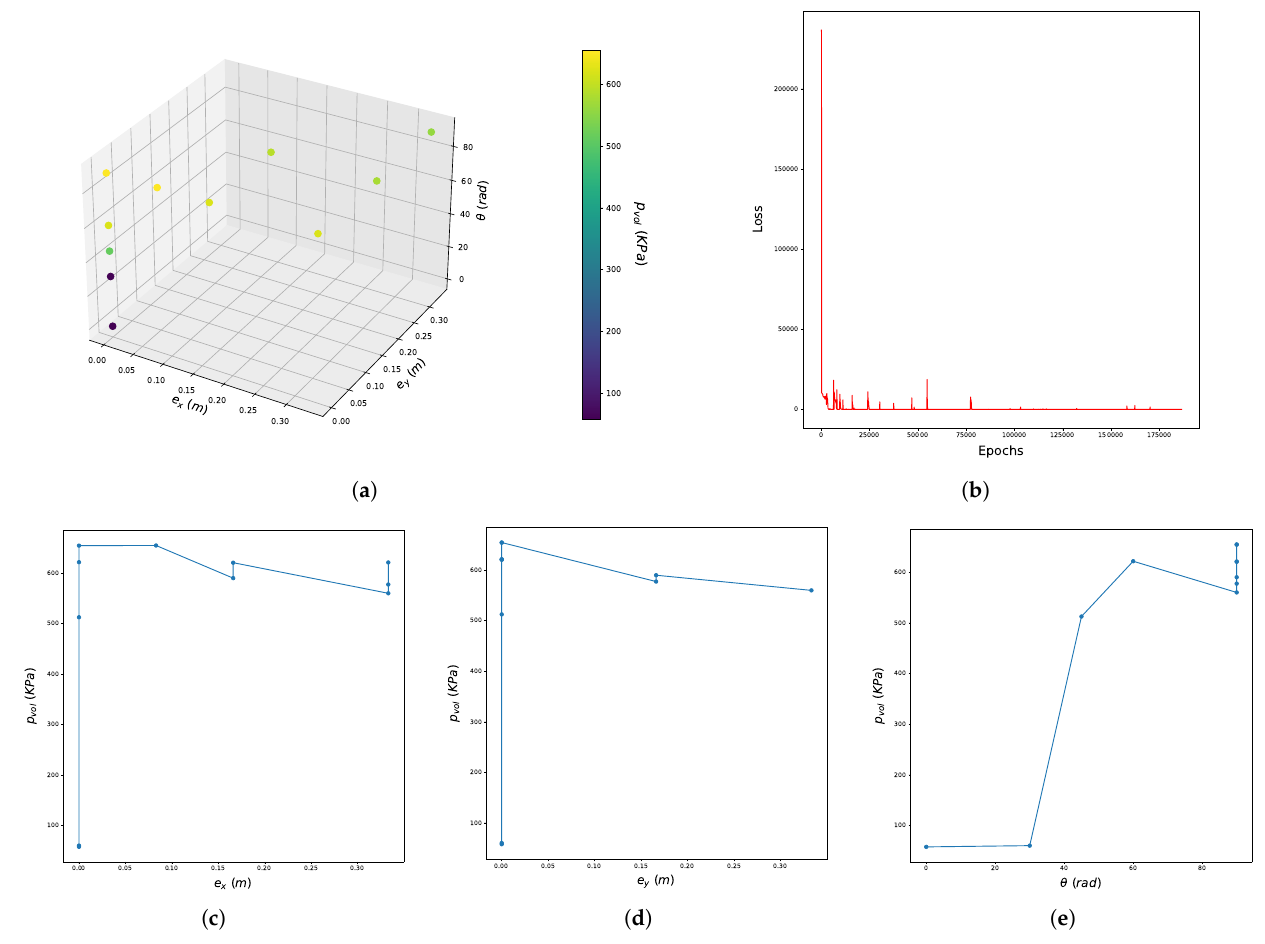
Figure 7. Graphical presentation of the Neural Network that corresponds to Monte Carlo analysis P - κ RF - c RF - k RF − 2 − 9 (NN9) for the estimation of the volumetric component of the stress p vol in kPa. ( a ) 3D representation of the Neural Network. ( b ) Epochs-Loss diagram. ( c ) Neural Network representation in the projection to the input axis of e x . ( d ) Neural Network representation in the projection to the input axis of e y . ( e ) Neural Network representation in the projection of the input axis of θ .